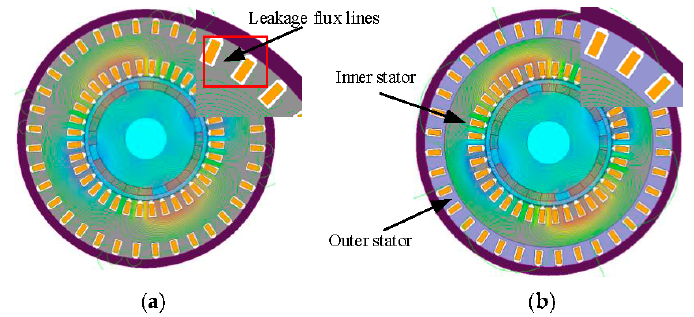
Figure 3. ( a ) Distribution of flux lines of undivided stator with toroidal windings; ( b ) cross-section of divided stator and distribution of flux lines with outer stator of non-magnetic material.